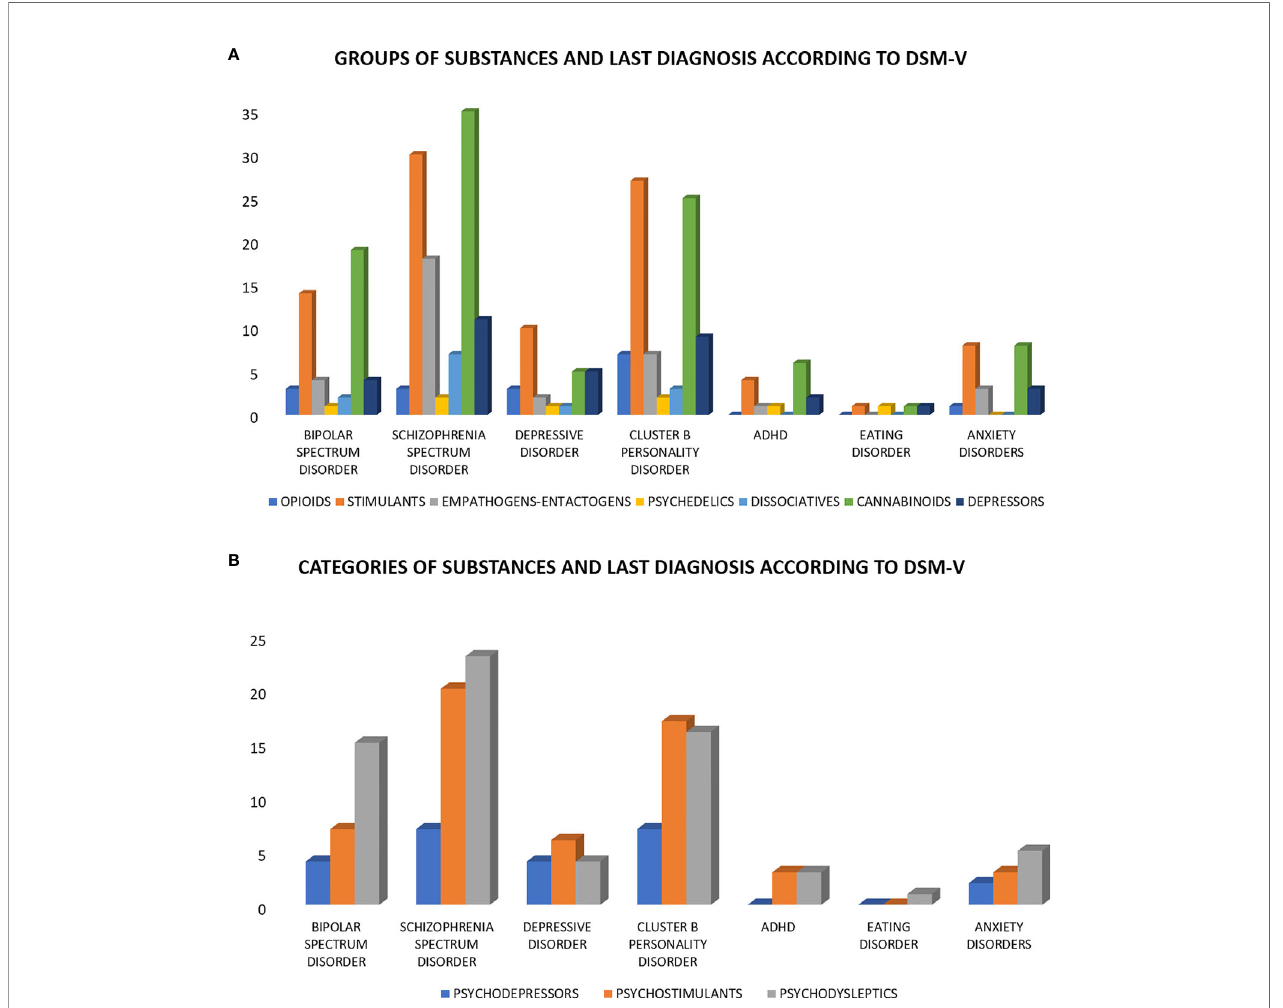
FIGURE 2 | Categories and groups of substances and last diagnosis according to DSM-V. (A) Last DSM-V diagnosis distribution according to the following groups of substances: opioids, stimulants, empathogens-entactogens, psychedelics, dissociatives, cannabinoids, and depressors. (B) Last DSM-V diagnosis distribution according to the following categories of substances: psychodepressors, psychostimulants, and